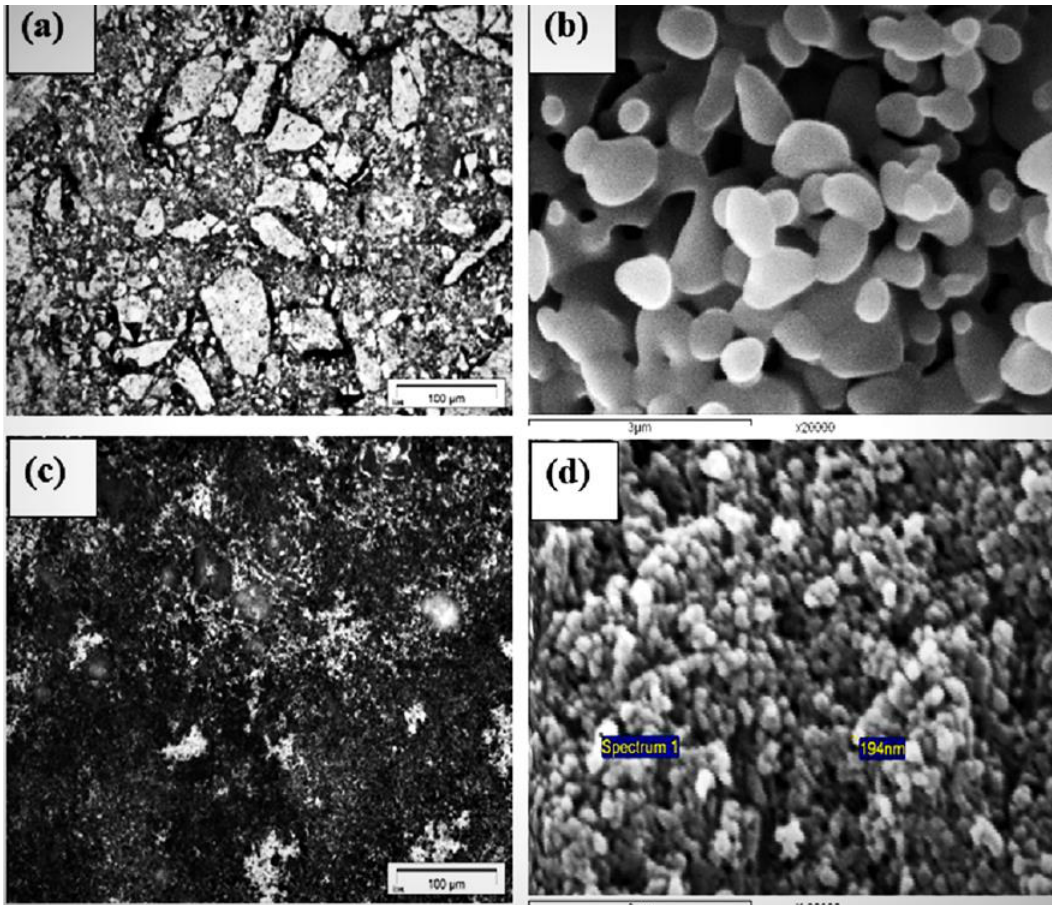
Figure 2. RLM photomicrographs and SEM image for precursor compacts thermally heated up to 500 °C in Ar gas atmosphere; ( a , b ) for precursor A; and ( c , d ) for precursor